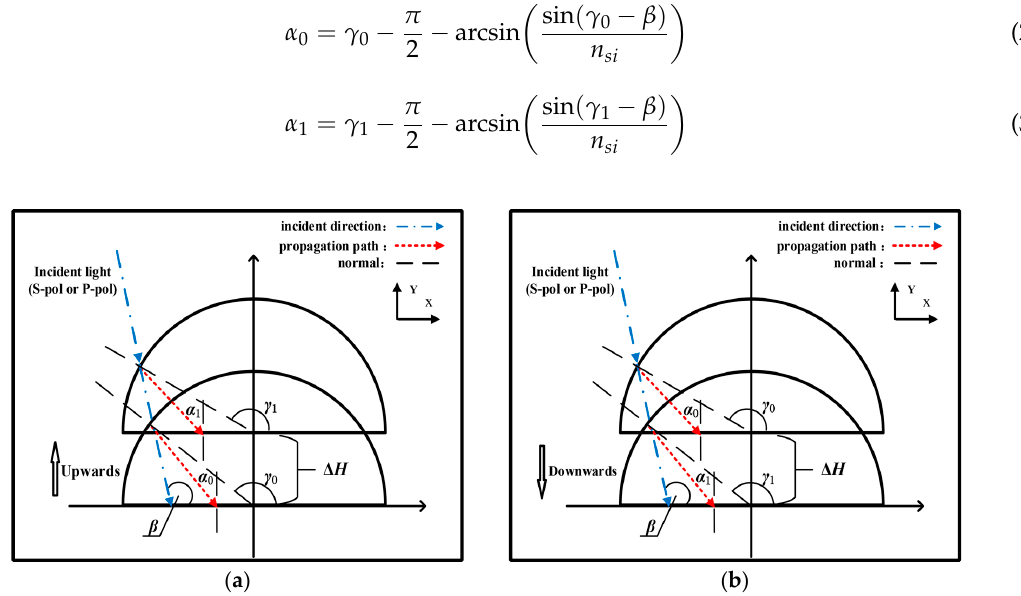
Figure 2. Change of displacement Δ H under perpendicular vibration. ( a ) Upward; ( b ) Downward.